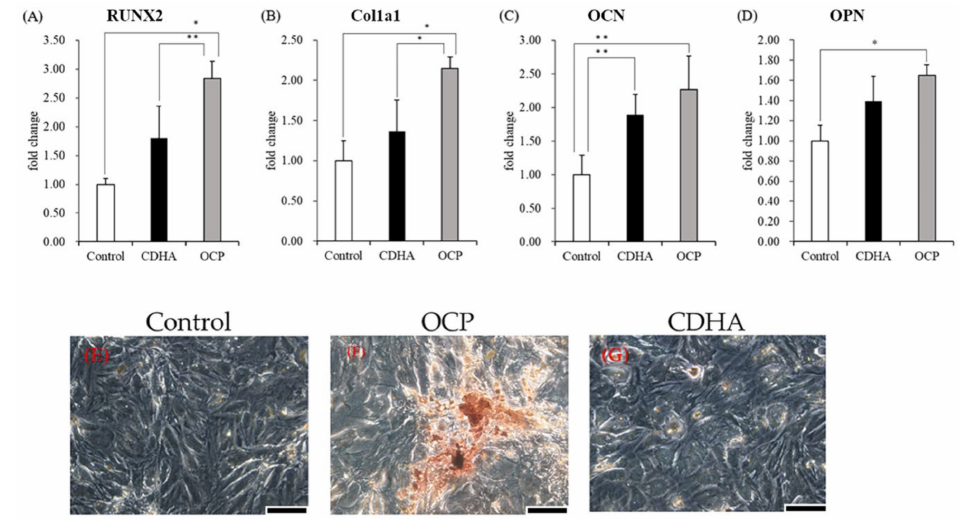
Figure 4. Effects of calcium phosphate granules for osteogenic differentiation in TSPCs; TSPCs treated with or without 4 mg of OCP and CDHA granules and cultured in cell culture insert system for 14 days; ( A – D ) the expression of the mRNA of osteogenic-related marker genes ( RUNX2 , Col1a1 , OCN , OPN ) ( n = 3); TSPCs treated in the Control ( E ), OCP ( F ), and CDHA ( G ) group as visualized by calcium nodules (red) with Alizarin Red staining, scale bars = 20 µ m, ** p < 0.01, * p < 0.05.